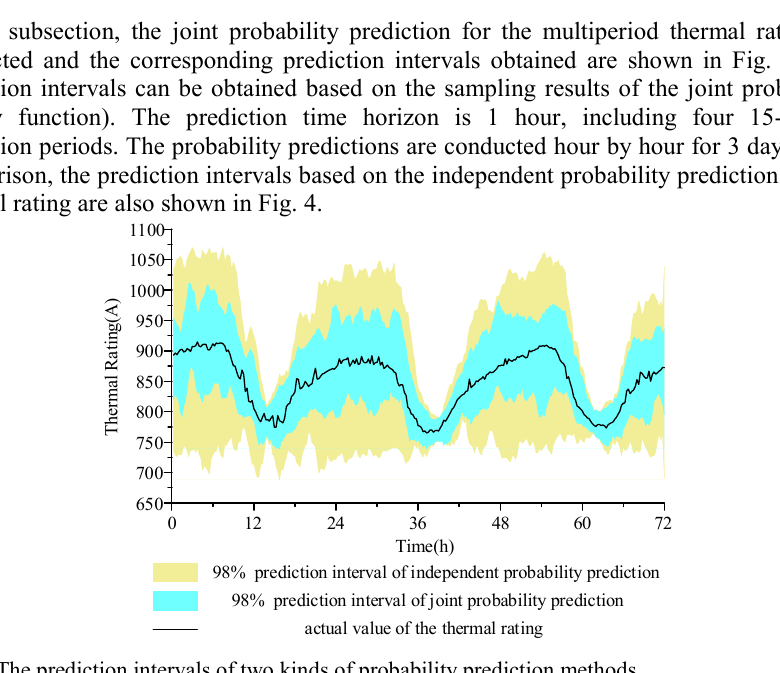
Fig. 4. The prediction intervals of two kinds of probability prediction